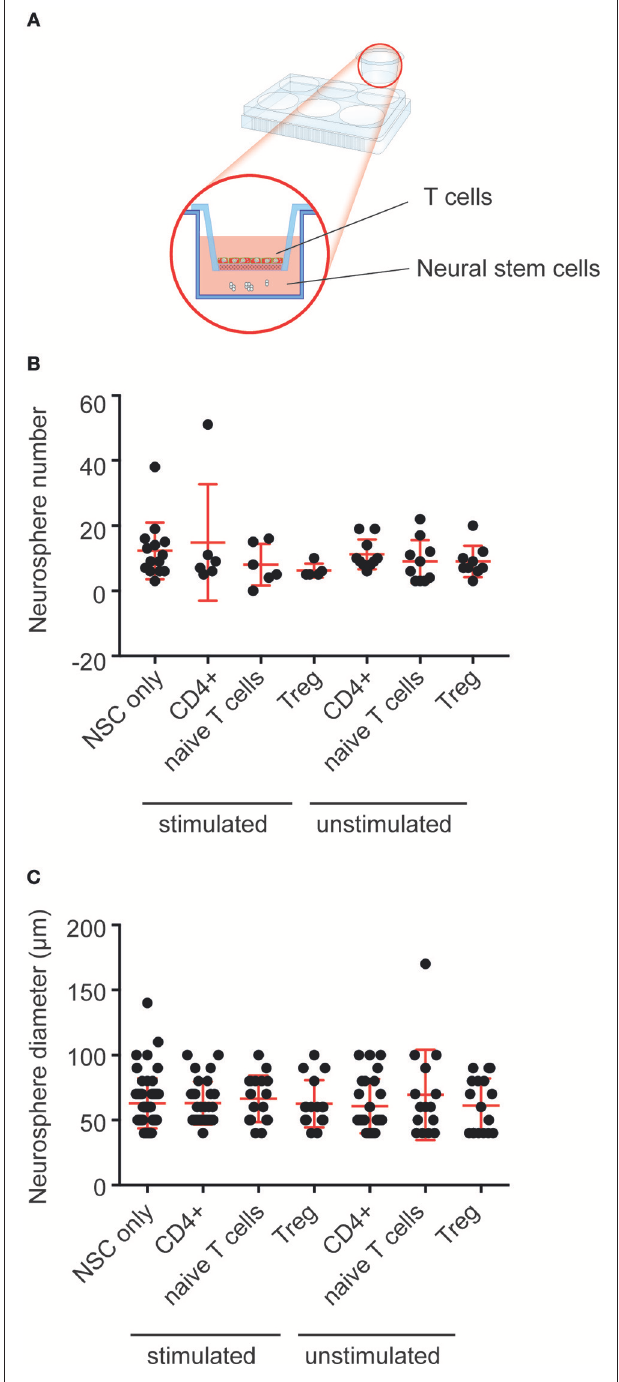
FIGURE 3 | Co-culture with T cells does not affect hippocampal neural precursor proliferation. (A) Depiction of the experimental set-up with T cells placed in trans-well inserts over primary hippocampal cells, which are cultured in the neurosphere assay. (B) No difference in neurosphere number was observed following co-culture of primary hippocampal cells with populations of T cells. (C) Co-culture with T cells had no effect on the size of the resulting neurospheres. Symbols and horizontal lines indicate individual neural stem cell preparations and mean values ± SEM, respectively. Data were analyzed using a one-way ANOVA with a Dunnett’s post-hoc